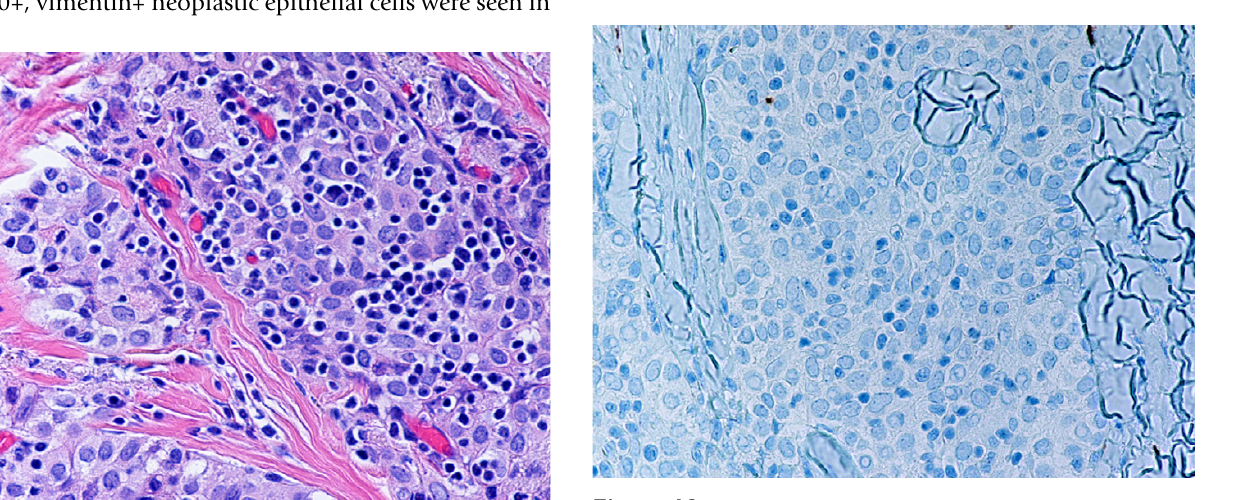
Figure 12 (B-SA, anti-CD20, × 400): Type B3 thymoma not associated with autoimmune disease. No CD20+ intratumoral lym- phocytes are